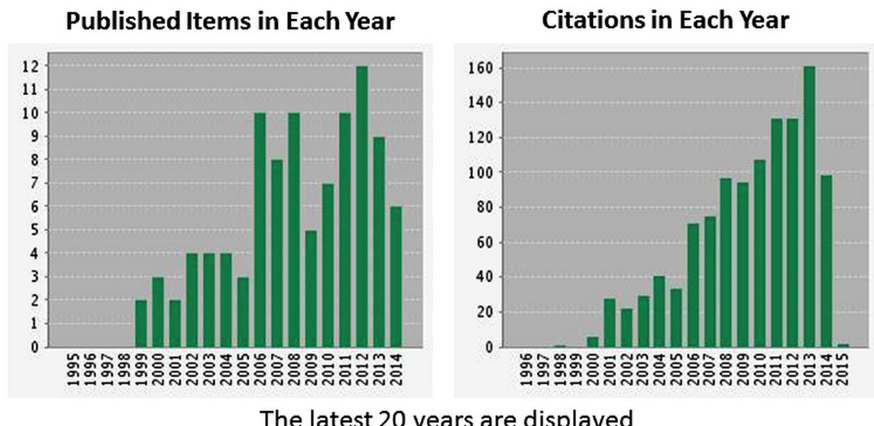
Fig. 1 - Published items and citations per